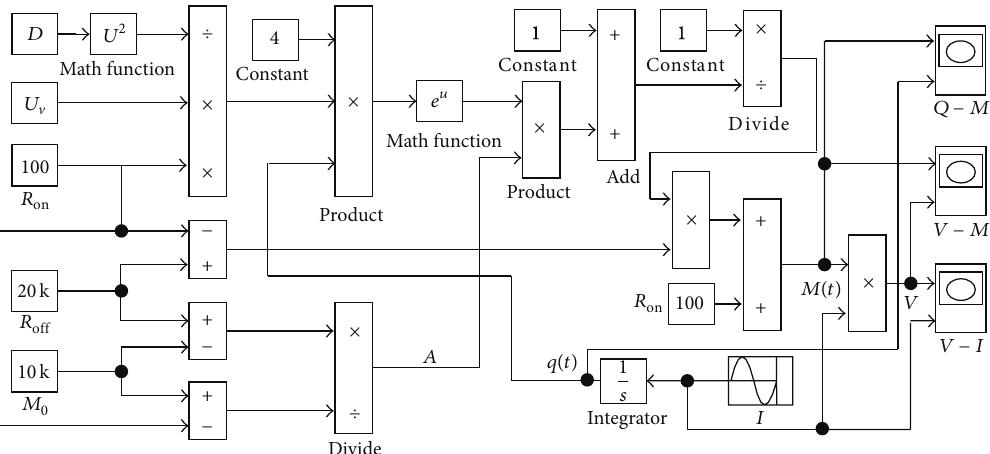
Figure 4: The Simulink model of the nonlinear